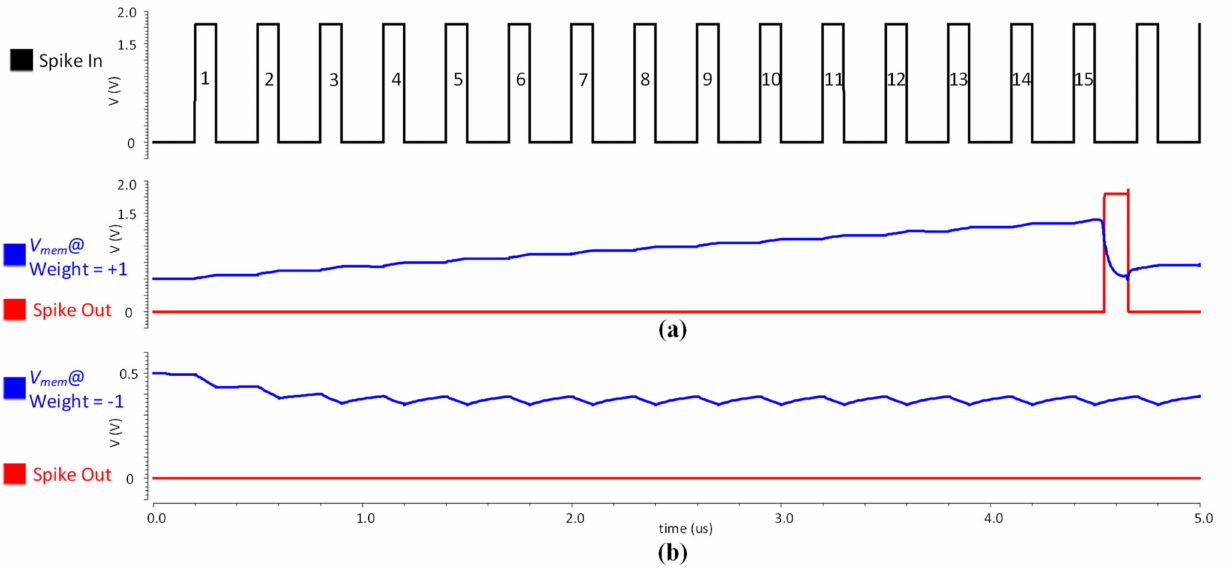
Figure 5. The circuit simulation results for one neuron cell of an input layer with an input spike train of 15 pulses: ( a ) shows the Vmem and spike-out when the weight value is +1; ( b ) shows the Vmem and spike-out when weight value is −